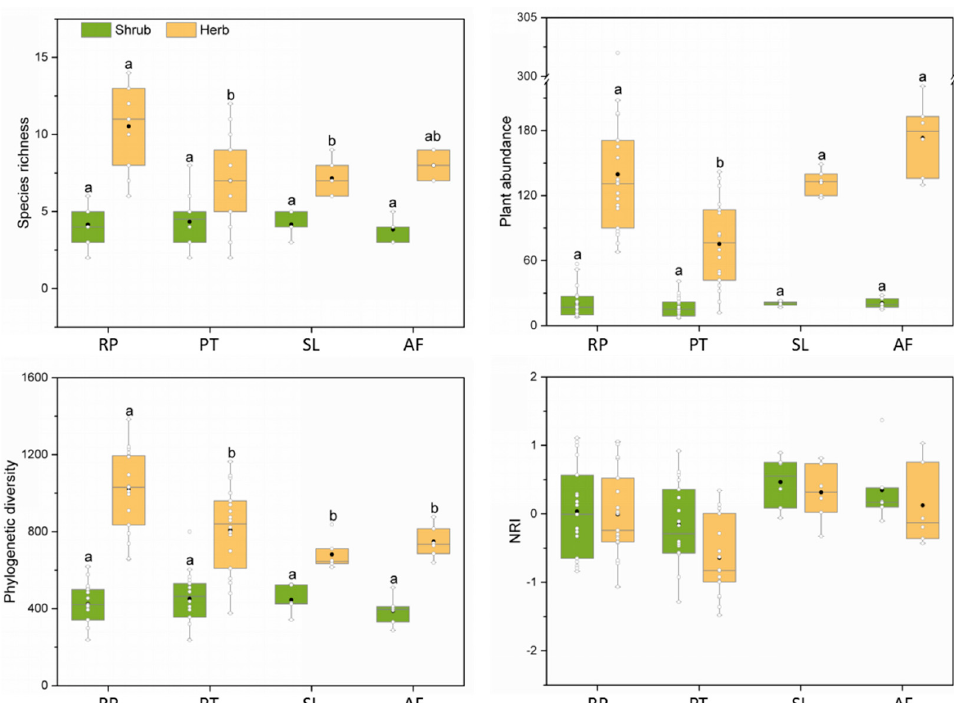
Figure 3. Species richness, plant abundance, phylogenetic diversity and NRI of different vegetation types. Different letters represent significant differences between different vegetation types ( p < 0.05). The black dot in the box is the mean. The white dots in the boxplot are the values of each sample plot. RP, R. pseudoacacia forest; PT, P. tabuliformis forest; SL, shrubland; AF, abandoned farmland.